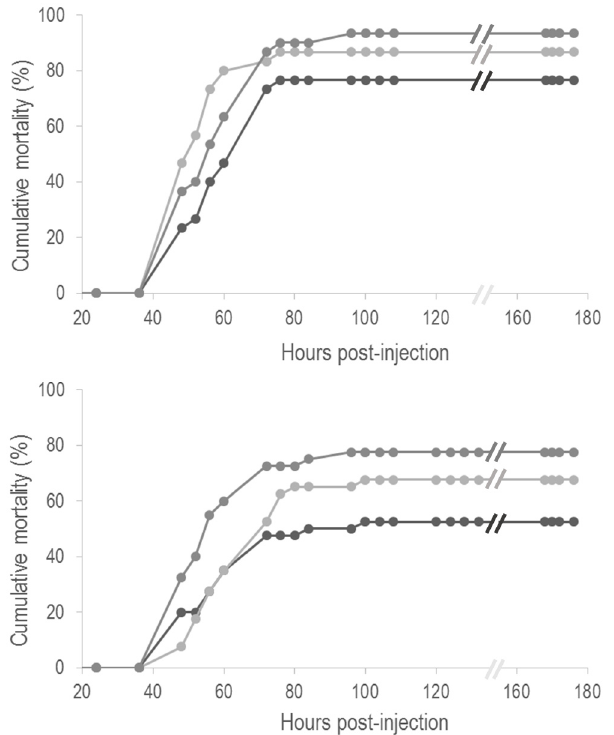
Fig 1. Cumulative mortality of European sea bass i.c. injected with V . anguillarum serotype O1 after 15 (1.5 × 10 4 CFU ml -1 , a) or 29 days (3 × 10 3 CFU ml -1 , b) of feeding with CTRL (black line), Arg1 (light grey line) or Arg2 (dark grey line) diets. Values are means of triplicate tanks (n = 30). SEM and sham injected fish are not presented for the clarity of the